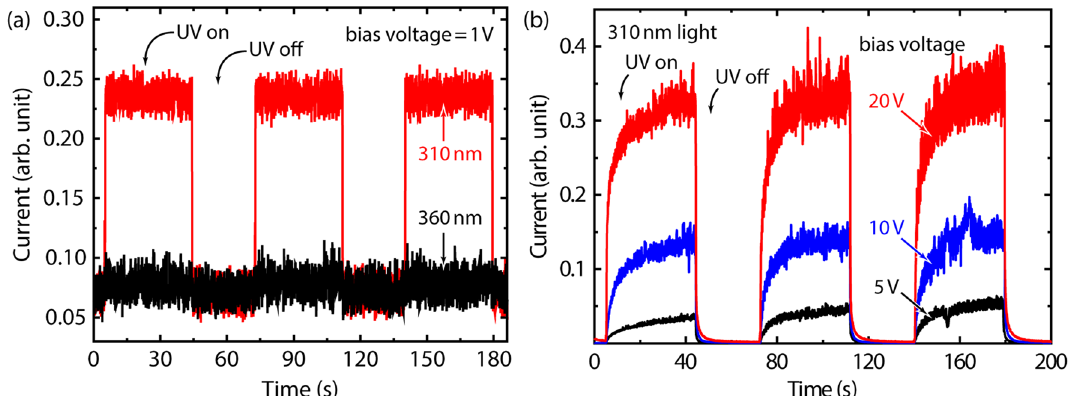
Figure 4. Temporal photoresponse of the Gr/AlGaN/GaN photodetector ( a ) at the bias voltage of 1 V under 310- and 360-nm illumination, ( b ) at the bias voltages of 5, 10, and 20 V under 310-nm